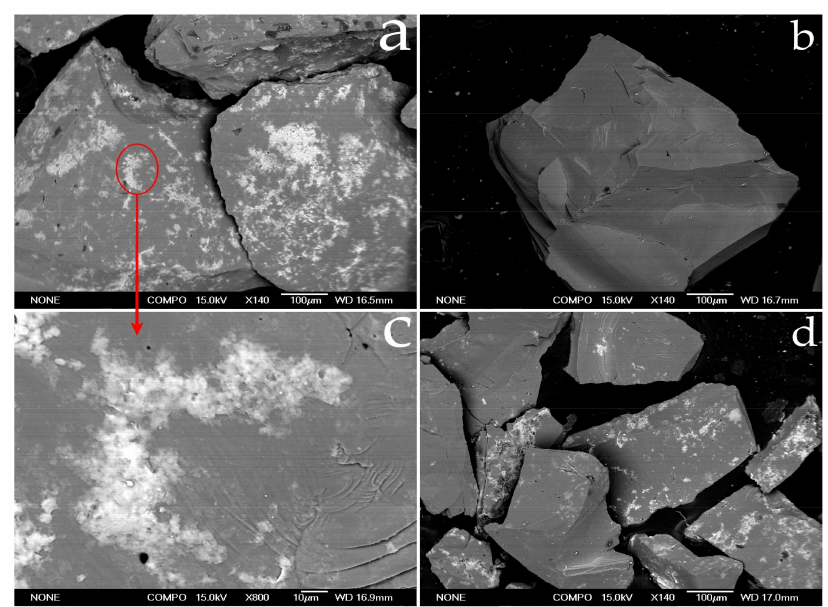
Figure 10. Scanning electron micrographs of the porous matrix from column inlet and outlet sections after the experiment: ( a ) inlet, V D = 1.62 m/d; ( b ) outlet, V D = 1.62 m/d; ( c ) close view of the indicated region in ( a ); and ( d ) inlet, V D = 0.46 m/d, the white material covered stand is iron